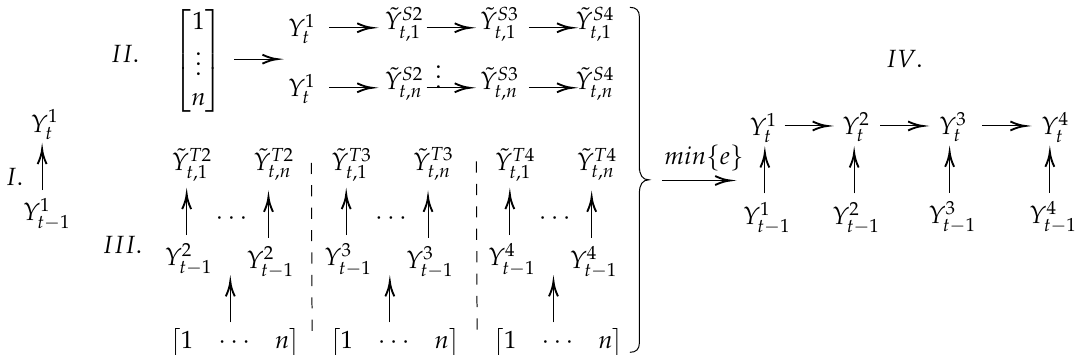
Figure 4. Four-dimensional generation algorithm. The roman numerals denote the steps of the algorithm. Superscripts S and T denote a realization according to spatial and temporal models, respectively. The tilde denotes a possible